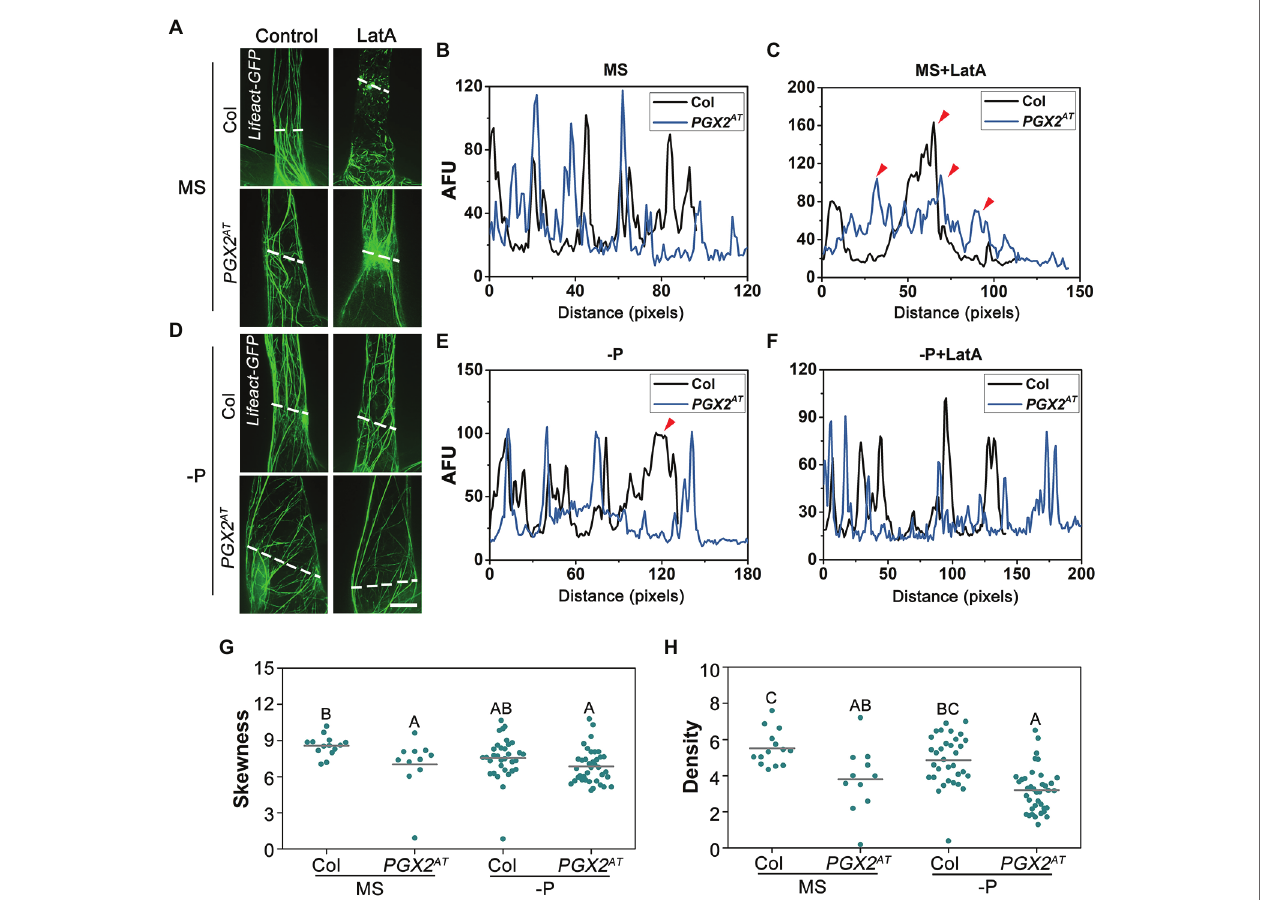
FIGURE 6 | Actin filaments in root hair cells of PGX2 AT seedlings show less skewness and more stable to LatA treatment. (A,D) Lifeact-GFP images of root hairs in 7-day-old Lifeact-GFP Col and Lifeact-GFP PGX2 AT seedlings under normal and P-deficient conditions without (Control) or with 100 nm LatA treatment. Bar = 10 μ m. (B,C,E,F) Profiles of fluorescent intensity along lines (perpendicular to cell growth axis) for Col (black line) and PGX2 AT (blue line) cells in (A) . AFU, arbitrary fluorescence units. Arrows indicate differences between two lines. (G,H) Skewness and density of actin filaments decrease in PGX2 AT seedlings ( n ≥ 11 cells). Uppercase letters indicate significantly different groups as determined by one-way ANOVA with post-hoc Duncan test ( p <